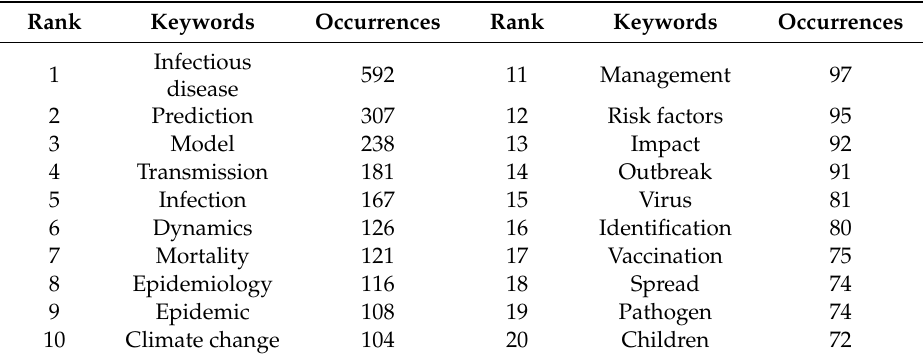
Table 4. The top 20 keywords about the field of the prediction of infectious diseases. Occurrences